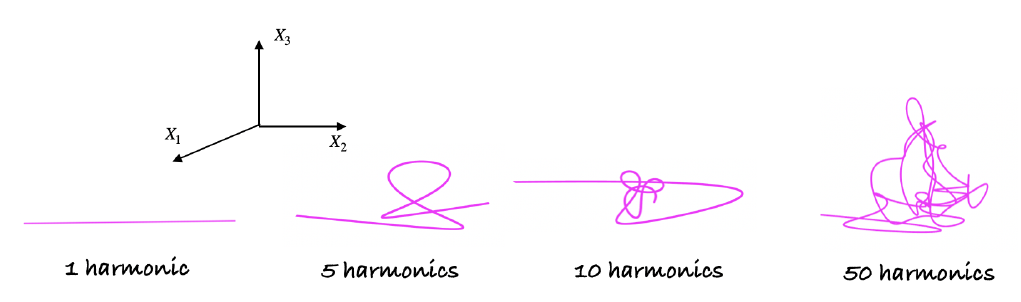
Figure 1 . Examples of 3D string profiles for different combinations of harmonics n ∗ = 1 , 5 , 10 , 50 with uniformly distributed random parameters a j